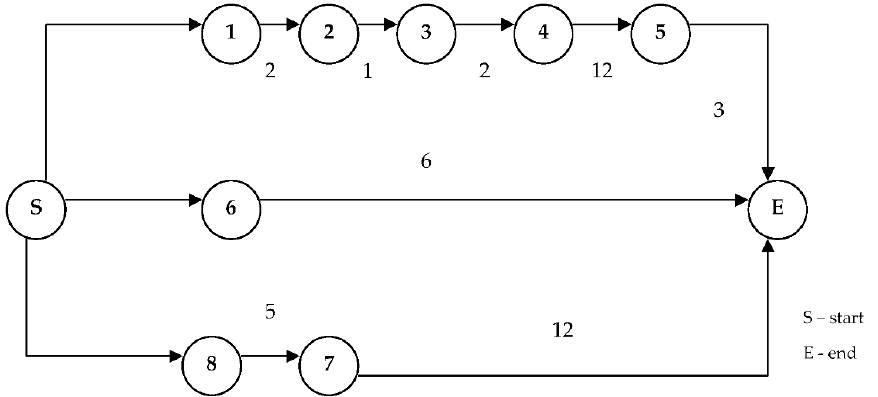
Figure 8. The arrow diagram to improve customer satisfaction.